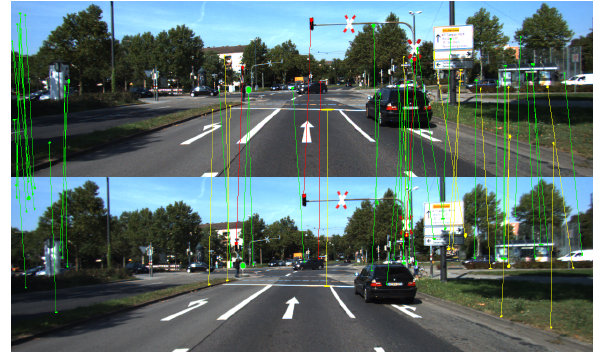
Figure 7: The red, yellow and green ellipses are matched in left and right